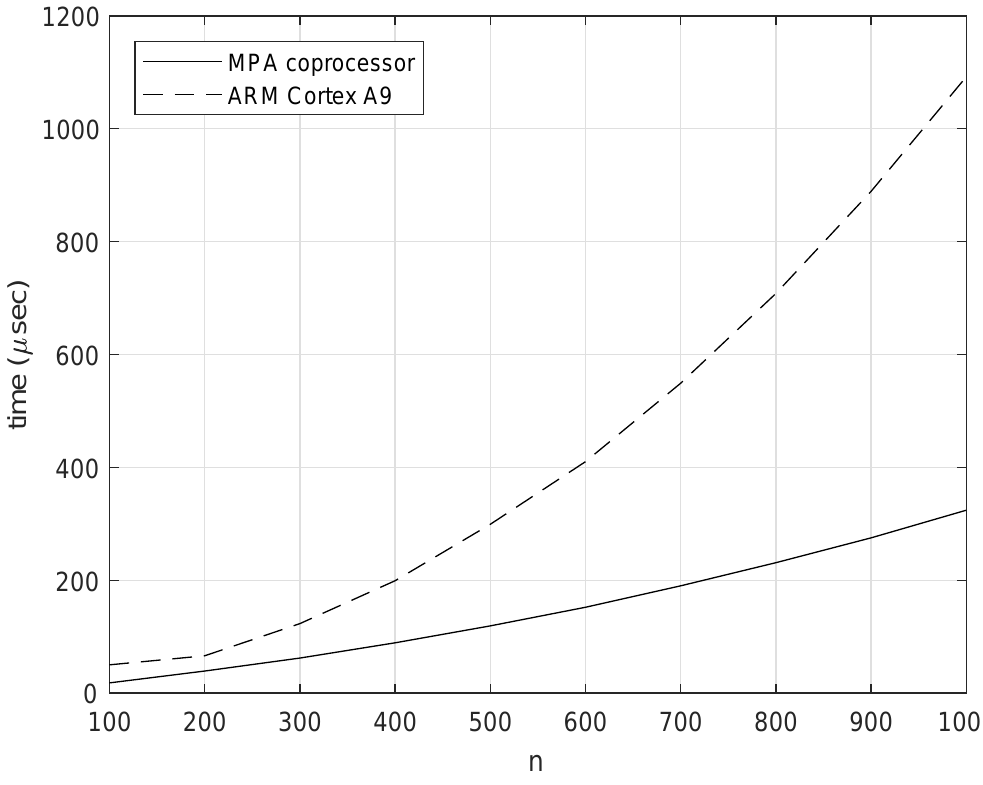
Figure 9. Runtimes for factorial computations ( n !).